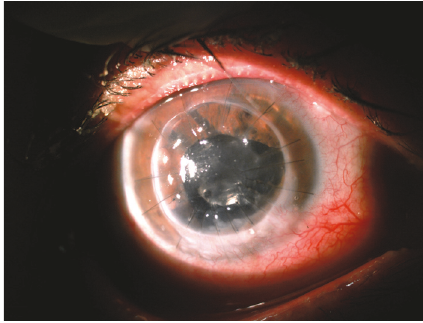
Figure 6: Clinical appearance of the patient two months after surgery, showing a complete resolution of infection, with conjuncti- valization replacing the area that was infected in the receptor